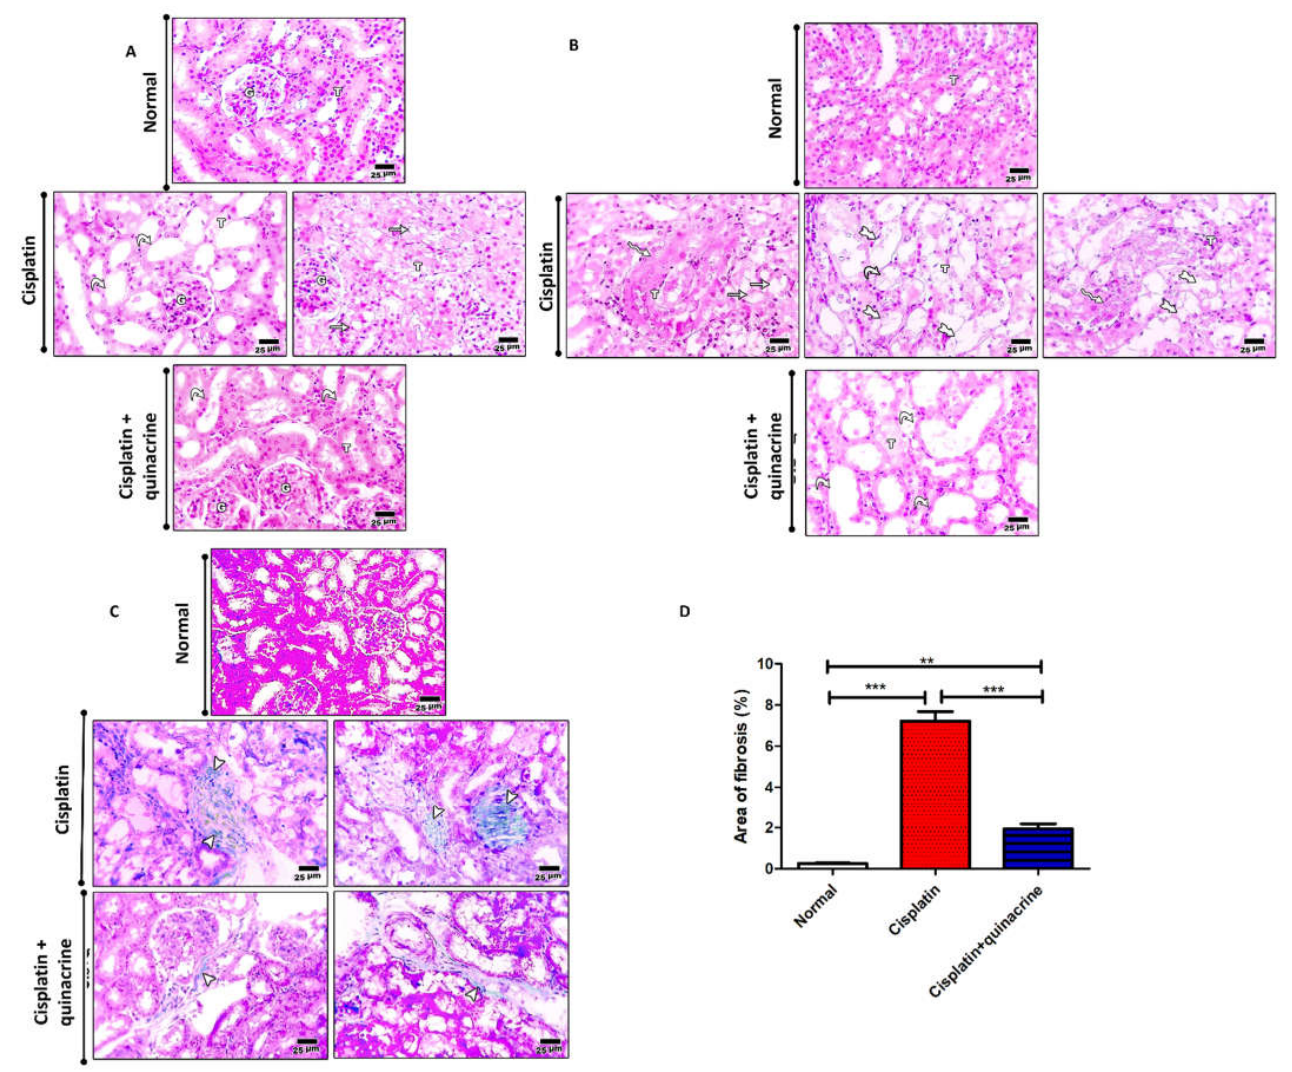
Figure 2. Quinacrine attenuated cisplatin-induced renal structure alteration and fibrosis. ( A ) Microscopic pictures of H&E-stained renal sections showing normal cortex including glomeruli (G) and tubules (T) in normal group, tubular dilation lined with flattened epithelium (curved arrows), vacuolar degenerative (arrows) in cortex of cisplatin group and mild tubular dilation lined with cuboidal epithelium (curved arrows) in cortex of cisplatin + quinacrine treated group. ( B ) Microscopic pictures of H&E-stained renal sections showing normal medulla cortex in normal group, marked tubular dilation (curved arrows), hydropic degeneration (rocket arrows) and necrosis (wavy arrows) in medulla in cisplatin group and moderate tubular dilation (curved arrows) in medulla of cisplatin + quinacrine group. ( C ) Microscopic pictures of Masson trichrome stained renal sections showing no fibrosis in normal group, bluish green fibrous tissue deposition (arrowheads) in renal sections from cisplatin group and the fibrous tissue deposition markedly decreased in cisplatin + quinacrine group. High magnification X: 400 bar 25. ( D ) The effect on area of fibrosis (%) of quinacrine administration (10 mg/kg/rat/ day: IP) against cisplatin-induced nephrotoxicity in rats ( n = 6). **: p < 0.01 and *** p < 0.001. Data are expressed as mean ±